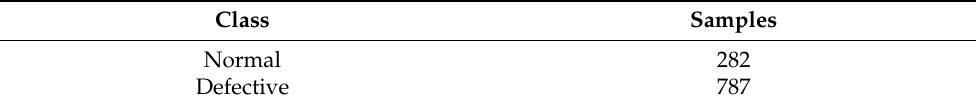
Table 2. Transformed dataset.